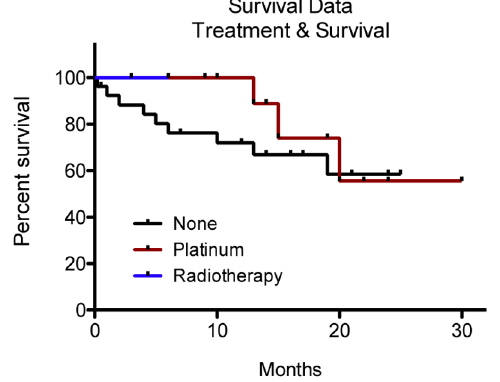
Figure 5. Patient survival was not significantly associated with ERCC1 nuclear expression H-score. There was no significant relationship between high or low intensity ERCC1 nuclear immunohis- tochemical labeling designated by H-score cutoff of 2.0 and patient survival. Chi- square =0.27; p=0.61. Median patient survival (months: ERCC1 + , 23.8; ERCC1-, 20.3, 95% CI of ratio: 0.8341 to 4.227.